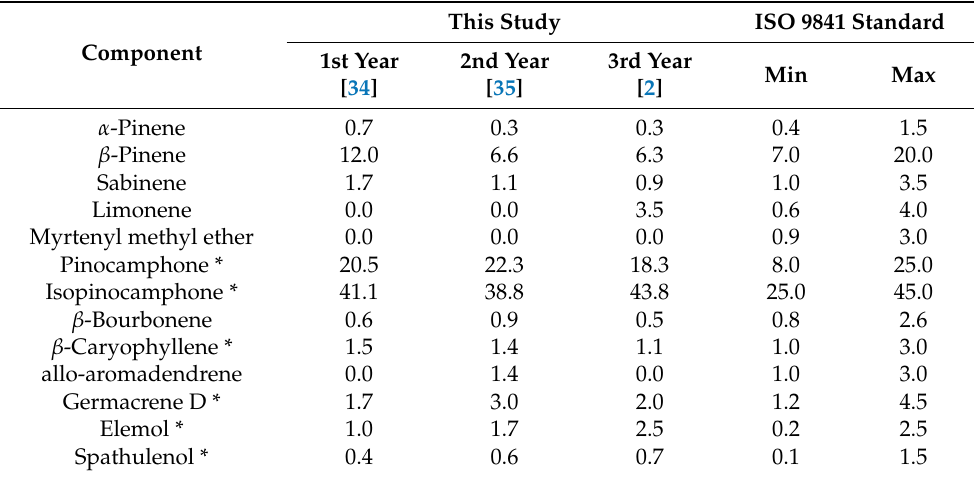
Table 3. Comparison results of main H. officinalis essential oil components from studies [34], [35] and [2], and ISO 9841